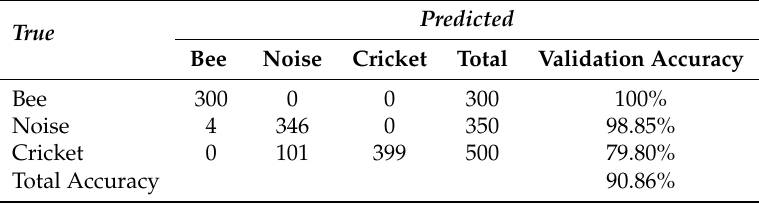
Table A3. Confusion matrix for RawConvNet with receptive field size n = 10 on BUZZ1 validation dataset.